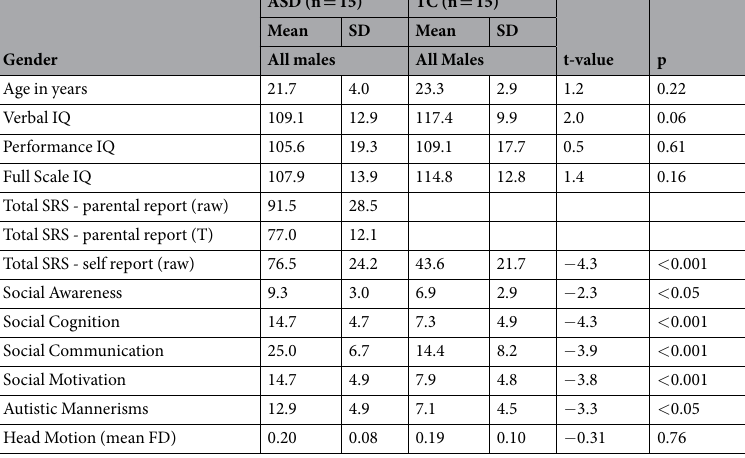
Table 1. Characteristics of the